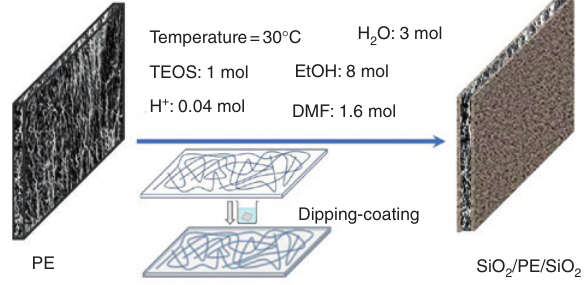
sol preparation and PE mem- 2